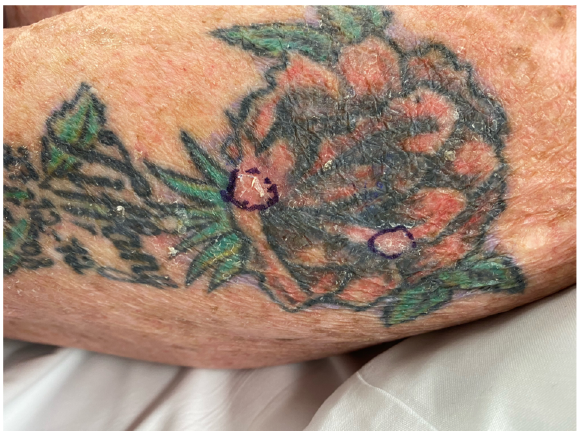
Figure 8. Clinical photograph of two scaly lesions of the skin located in the red-inked areas of a multi-coloured tattoo of the left arm completed 13 years earlier. multi-coloured tattoo of the left arm completed 13 years